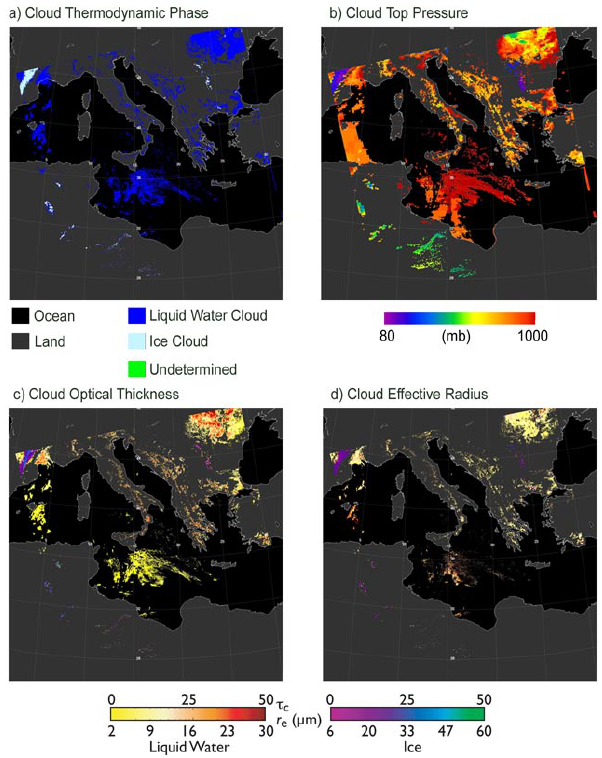
Fig. 3. Actual cloud retrieval for Aqua MODIS 2012 day 228 at 12:00UTC. (a) is cloud thermodynamic phase, (b) cloud top pres- sure, (c) cloud optical thickness and (d) cloud effective radius from the 0.86–2.1µm band combination.